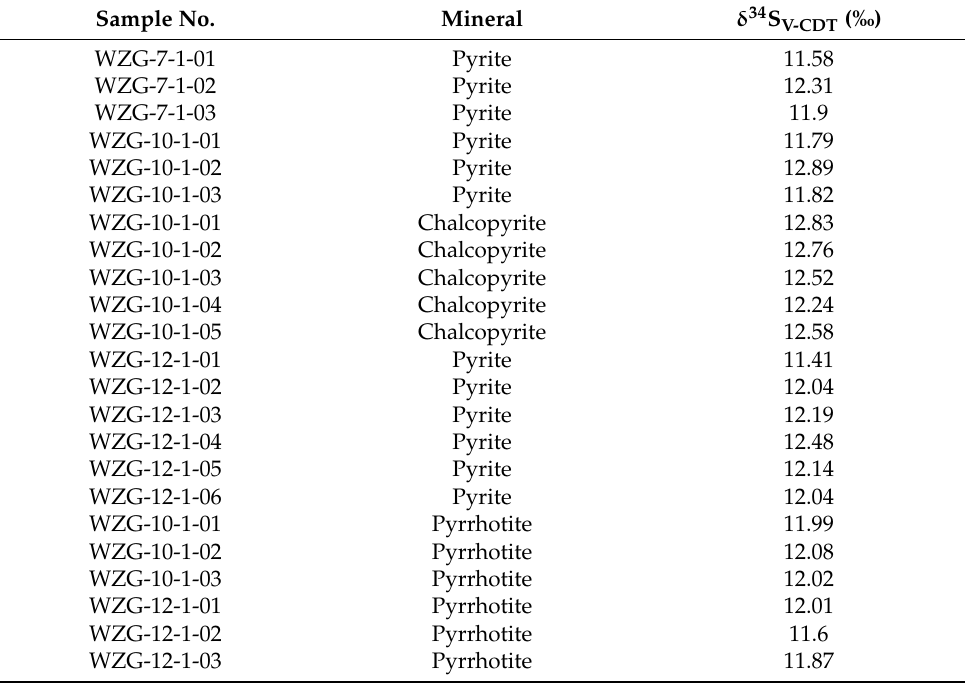
Table 5. In situ sulfur isotopic compositions of sulfides from the Weizigou deposit. Sample